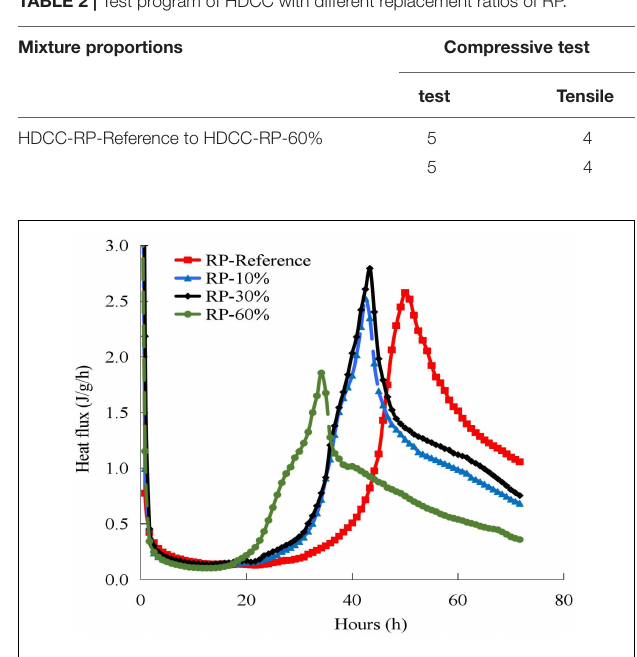
FIGURE 5 | Hydration evolution of HDCC.